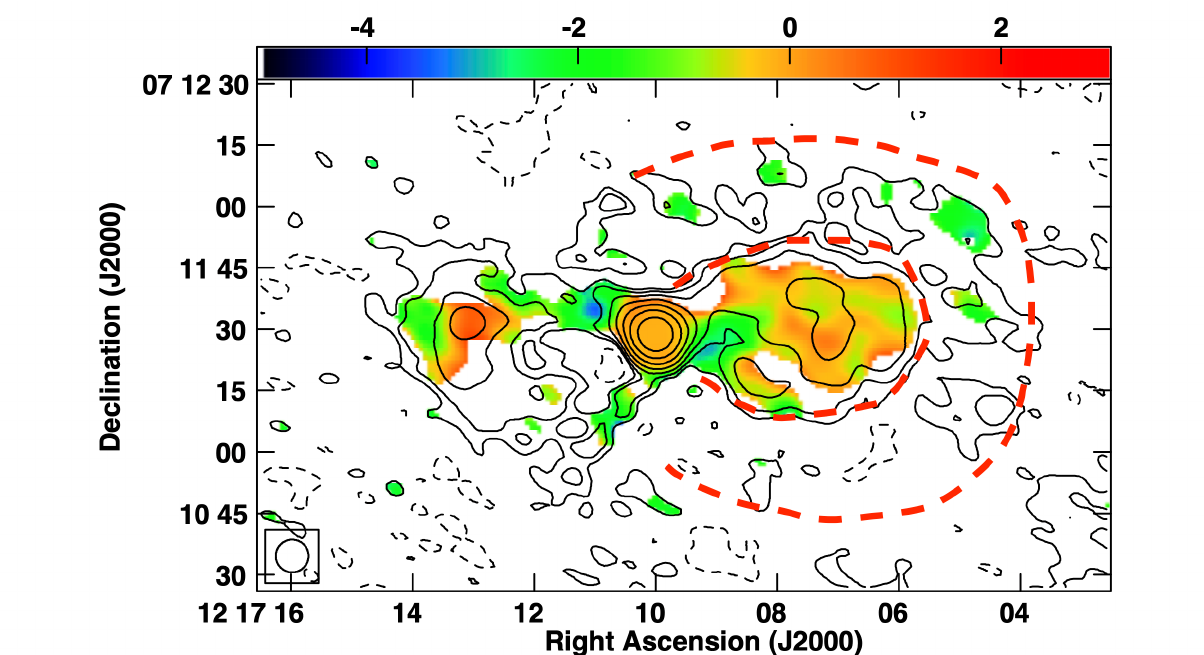
Figure 1. The 325–610 MHz spectral index image from the GMRT in color overlaid with the 610 MHz radio contours for the Seyfert galaxy NGC4235. The average spectral index is ∼− 0.6 in the lobes and ≤− 1.8 in the “relic” lobe (emission between the red dotted lines). The contour levels are in percentage of the peak intensity and increase by factors of two. The peak intensity and lowest contour levels are 2.3 × 10 − 2 Jy beam − 1 and ± 0.3% of the peak intensity, respectively. The contour image is convolved with a circular beam of size 8 arcsec. Image reproduced from Kharb et al.